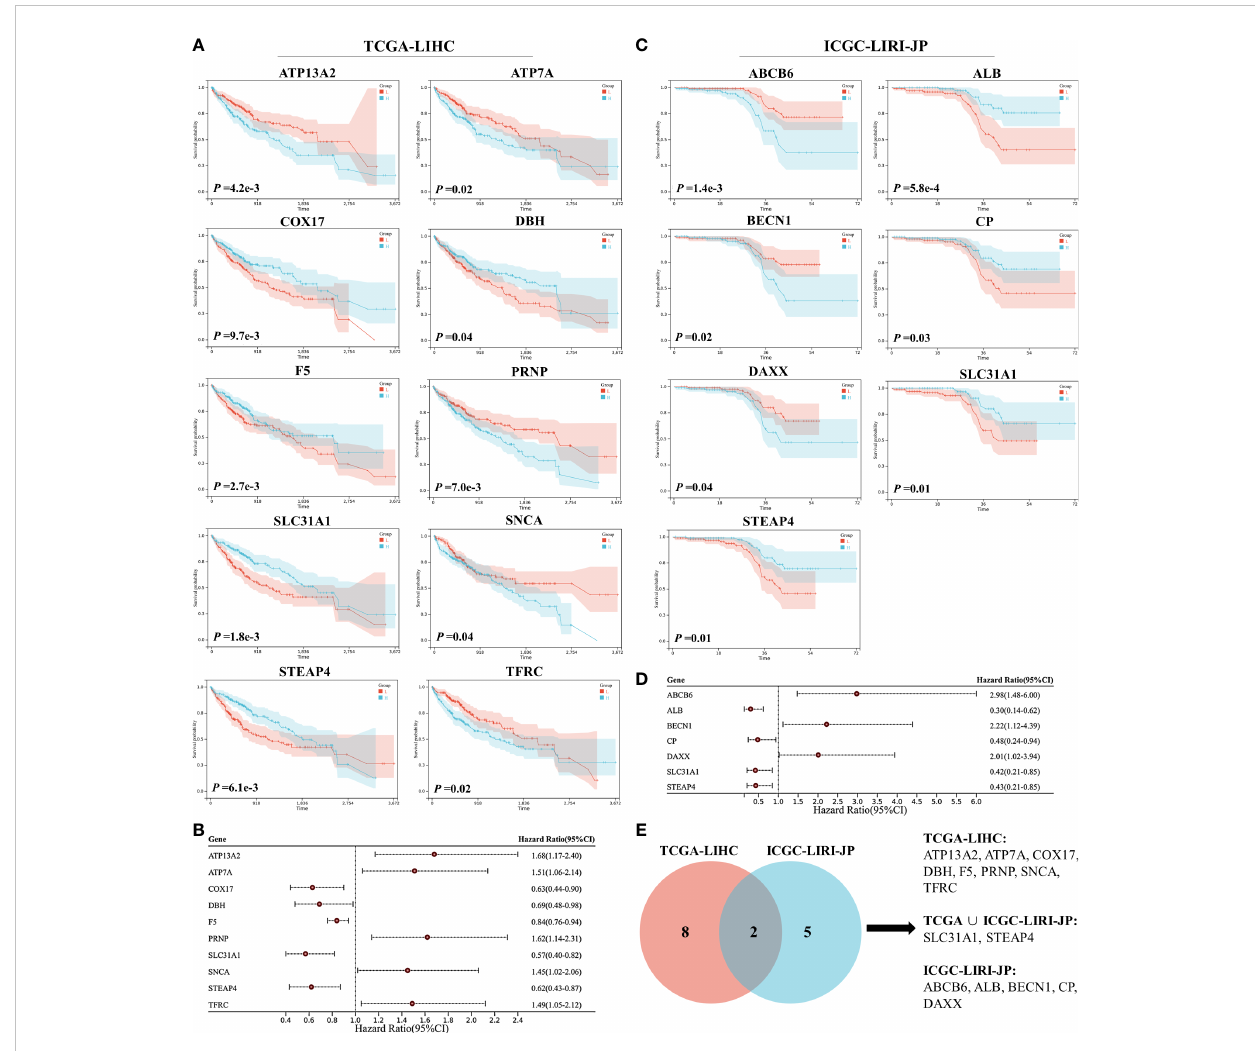
FIGURE 1 Survival analyses of cuproptosis-related genes (CRGs) for patients with hepatocellular carcinoma (HCC) in the TCGA-LIHC and ICGC-LIRI-JP datasets. (A) Survival analyses of CRGs for patients with HCC in the TCGA-LIHC dataset. (B) Forest plot of prognostic genes in the TCGA-LIHC dataset. (C) Survival analyses of CRGs for patients with HCC in the ICGC-LIRI-JP dataset. (D) Forest plot of prognostic genes in the ICGC-LIRI-JP dataset. (E) Venn diagram of prognostic genes in the two